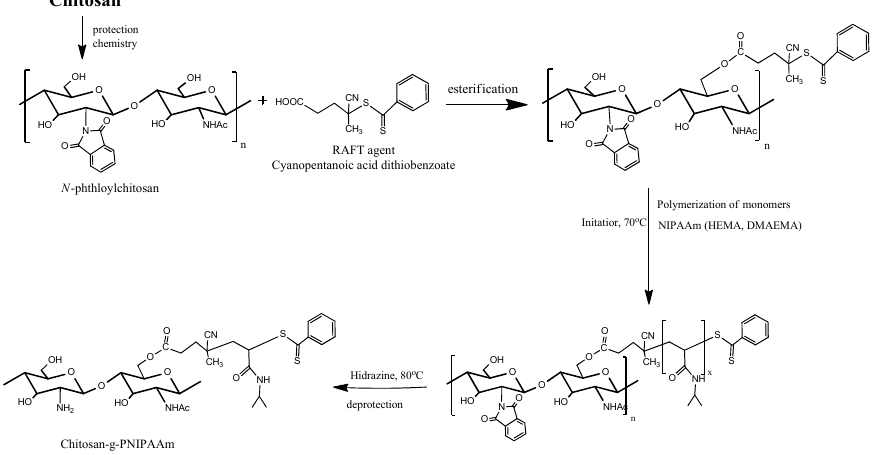
Figure 1. Synthesis approach of the CS-g-PNIPAAm via RAFT polymerization.